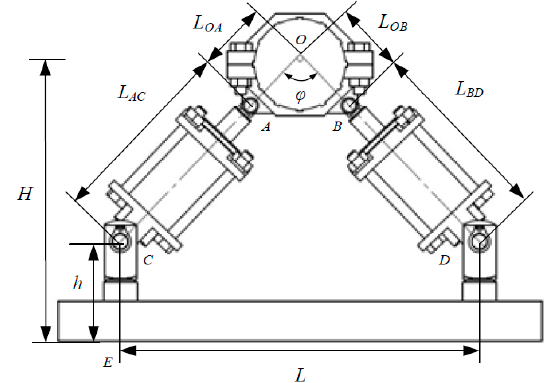
Figure 3. Installation position of the MR damping clamp.